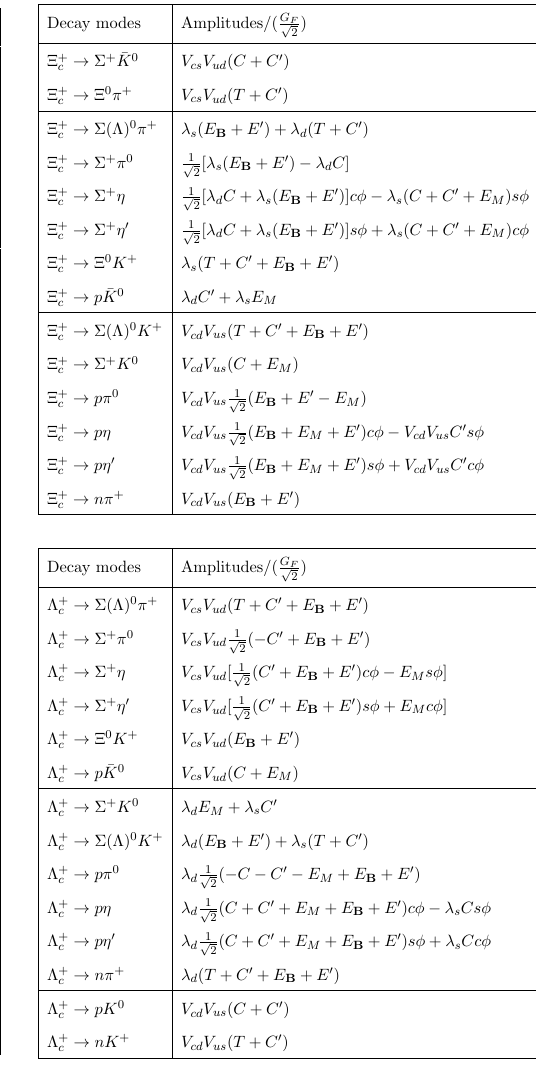
B M , where (cid:21) q V cq V uq with q = ( d; s ) and ( s(cid:30); c(cid:30) ) (sin (cid:30); cos (cid:30) ) ! (cid:17) (cid:17) ((cid:4) + (cid:4) (cid:0) (cid:25) + (cid:25) + ) = (2 : 86 1 : 21 0 : 38) 10 (cid:0) 2 [49]. We adopt c ! B (cid:6) (cid:6) (cid:2)